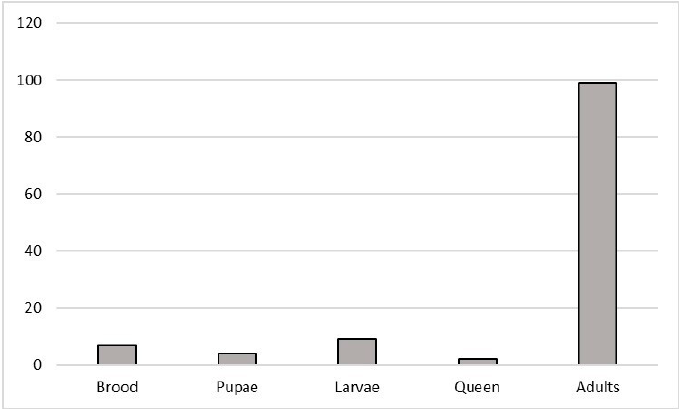
Figure 2. Number of studies, divided by a methodological approach, on Apis mellifera , that met the criteria for inclusion in this review.